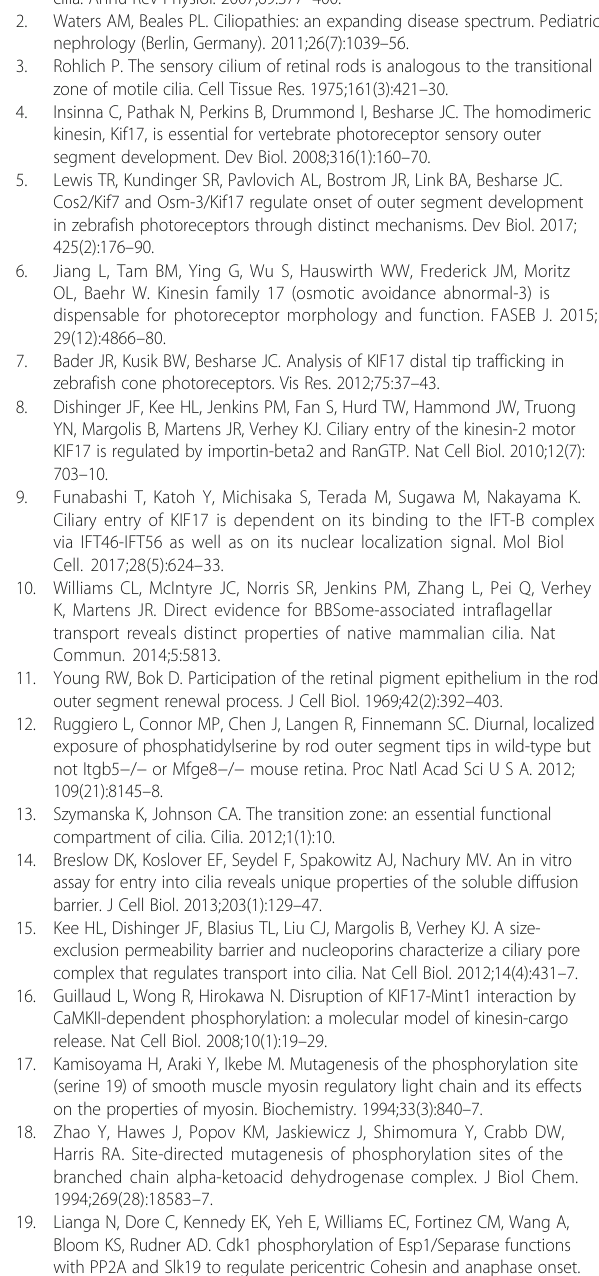
ding. Figure S6. Opsin expression is largely unaffected by transgene expression. Figure S7. Rhodopsin immunogold labeling of phagosomes. Figure S8. Cone transducin- α immunogold labeling of phagosomes . Fig- ure S9. Spline interpolation of zebrafish disc shedding data. Table S1. Spline interpolation of zebrafish disc shedding. Table S2. Spline interpolation of mouse disc shedding. (DOCX 5111